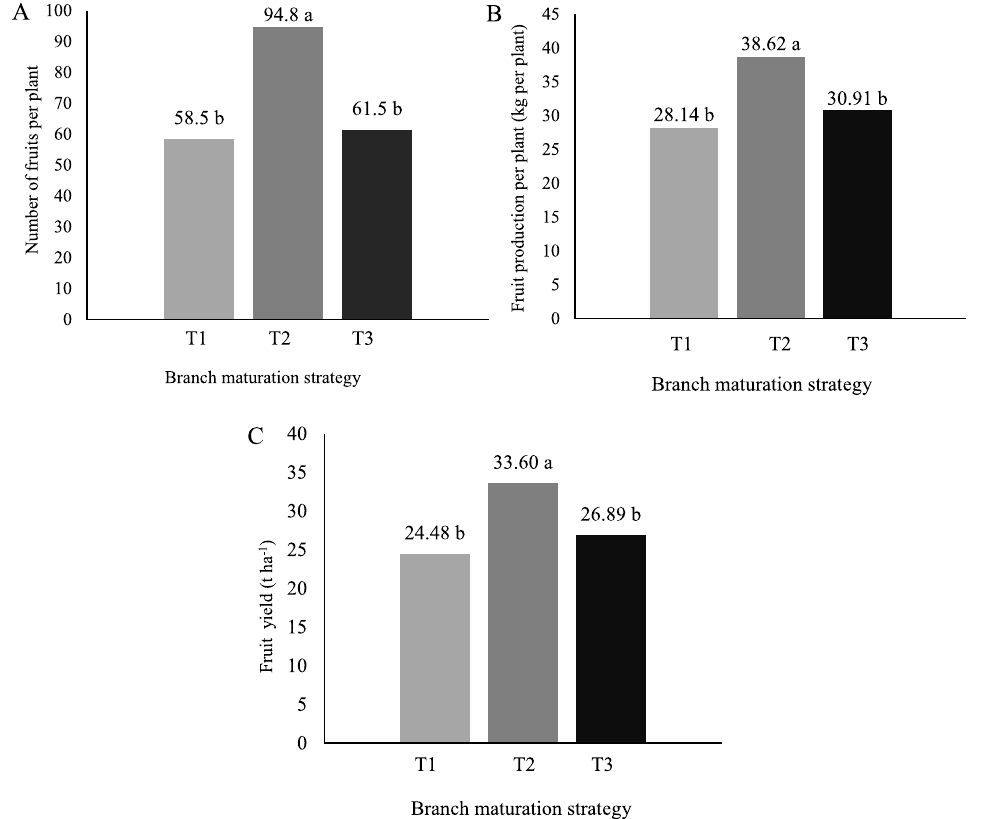
Fig. 4: Number of fruits per plant (A), (B) and commercial fruit yield (C) of mango cv. Palmer as a function of shoot maturation strategy. Bars with the same letters do not differ in among themselves by Tukey’s test at 1% probability in each evaluation date. T1) biostimulant foliar spray + K fertilizer; T2) foliar spray with biostimulant alternating with K fertilizer; T3) individual foliar sprays (magnesium sulfate, potassium sulfate, sulfur and calcium fertilizers, potassium fertilizer, and Ethrel ® ; and T4) Control